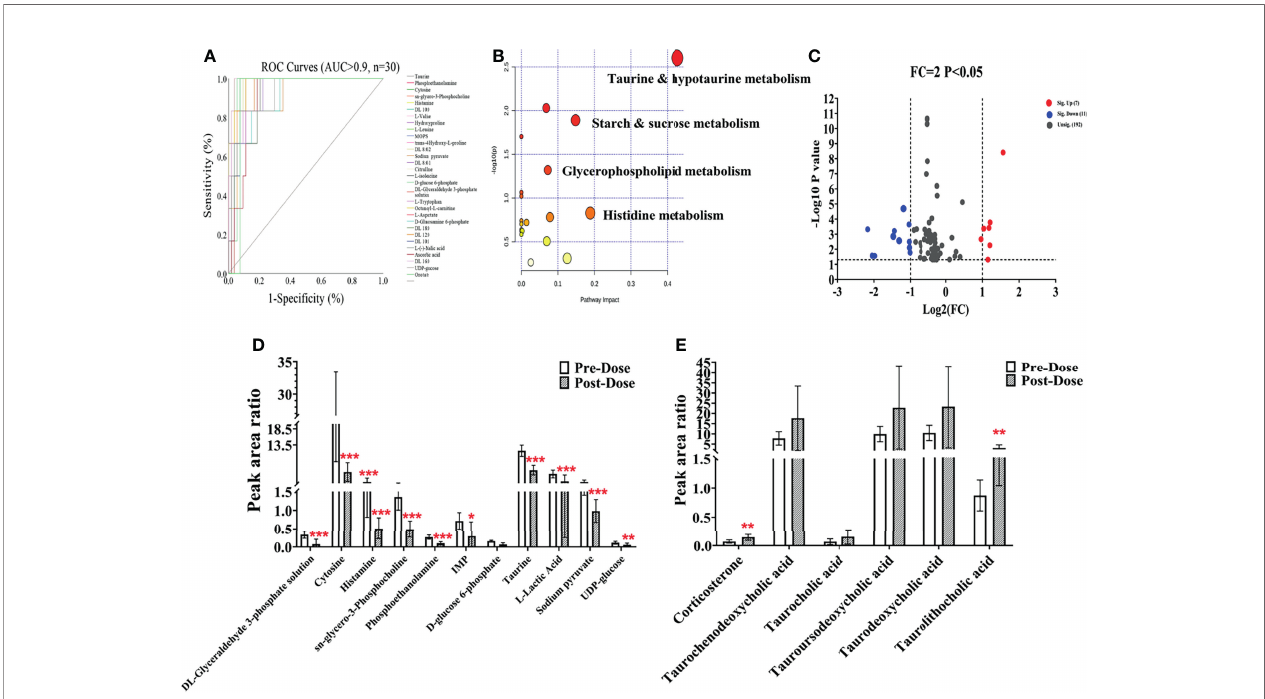
FIGURE 6 | Metabolic changes after sotorasib treatment. (A) Receiver operating characteristic (ROC) curves of the metabolites administered sotorasib (AUC > 0.9, n = 30). (B) Overview of the pathway enrichment analysis of the altered metabolites between pre- and post-doses. (C) Volcano map of the metabolites with variable importance in the projections (VIP) >1 and fold change (FC) values >2 and <0.5 ( p < 0.05). (D, E) Downregulated ( n = 11) (D) and upregulated ( n = 6) (E) metabolites compared with the pre-dose group. *p < 0.05; **p < 0.01; ***p <